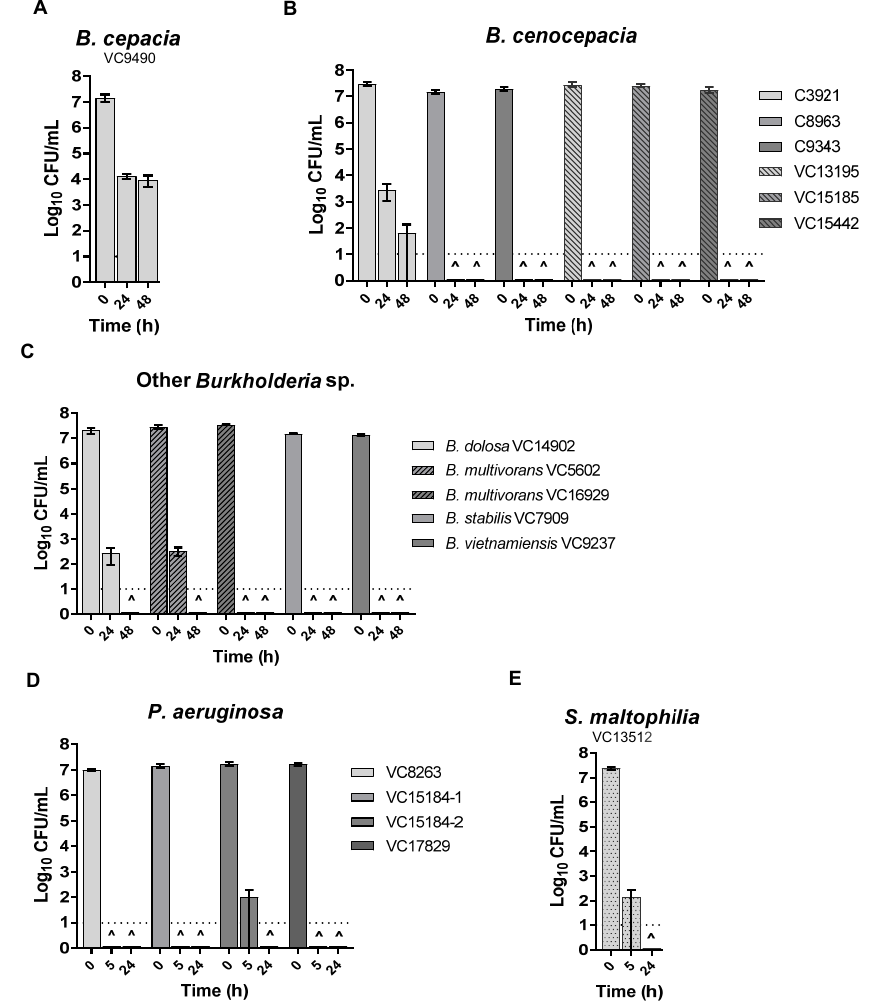
Figure 1. Effect of aqueous suspensions of KC on the viability of isolates: 10% ( w / v ) against B. cepacia complex isolates ( A – C ) and 1% ( w / v ) against P. aeruginosa isolates ( D ) and S. maltophilia isolate ( E ). CFUs have been determined at 0 h, 5 h, 24 h, and 48 h of incubation. ^ indicates that no viable cell could be recovered at that time point. Error bars represent the standard error (SE) of the mean of three independent replicates of each strain. The dotted line at log 10 = 1 of the Y axis represents the limit of detection for